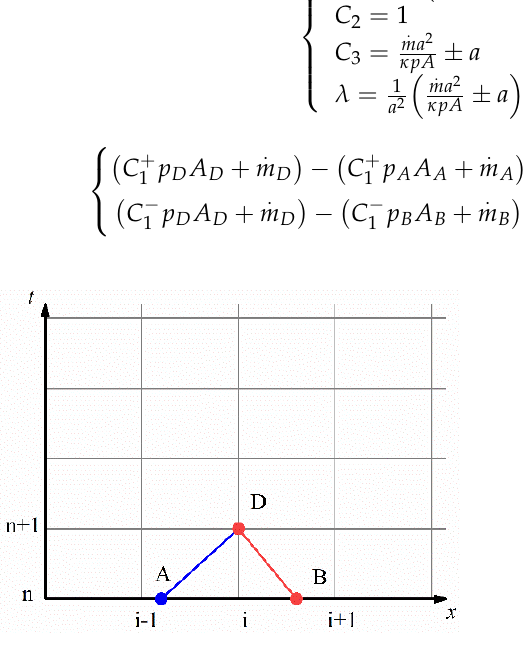
Figure 6. Schematic of characteristic line.